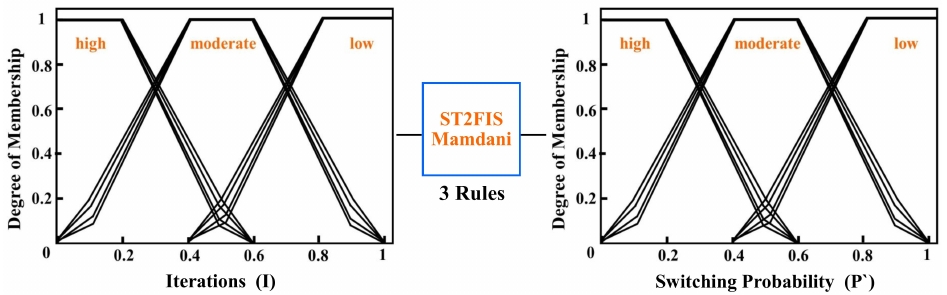
Figure 8. Dynamic parameter adaption of fuzzy FP algorithm using